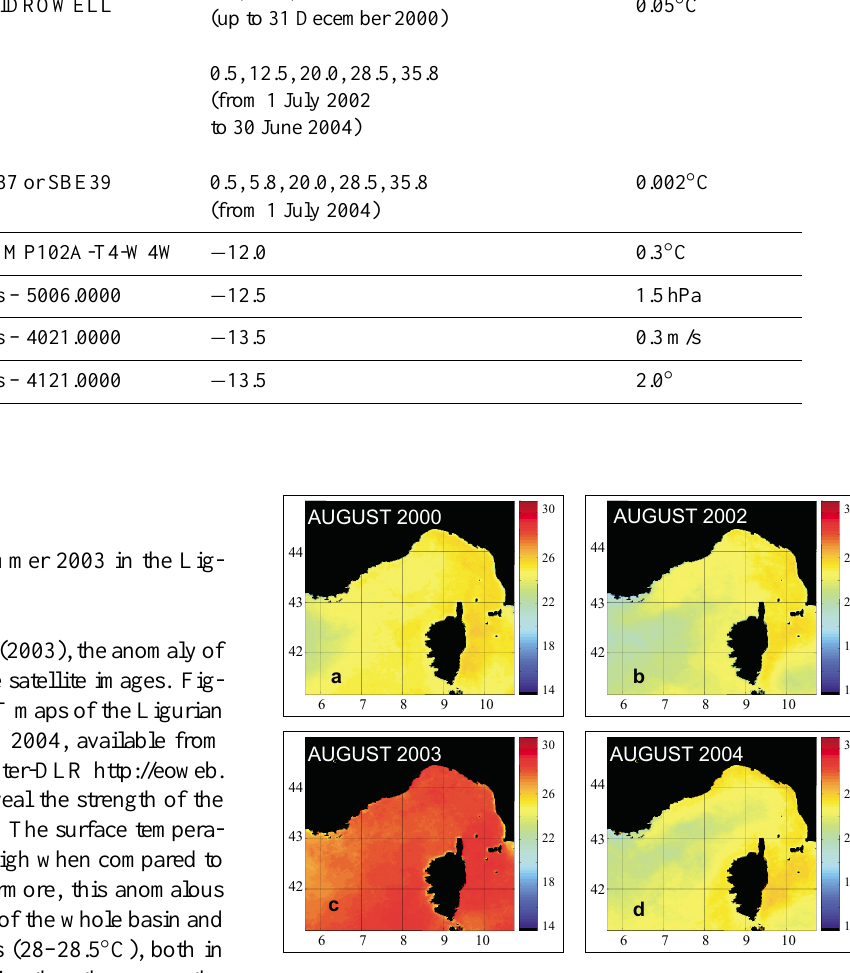
Fig. 2. Monthly averaged SST of the Ligurian Sea in (a) August 2000, (b) August 2002, (c) August 2003 and (d) August 2004.